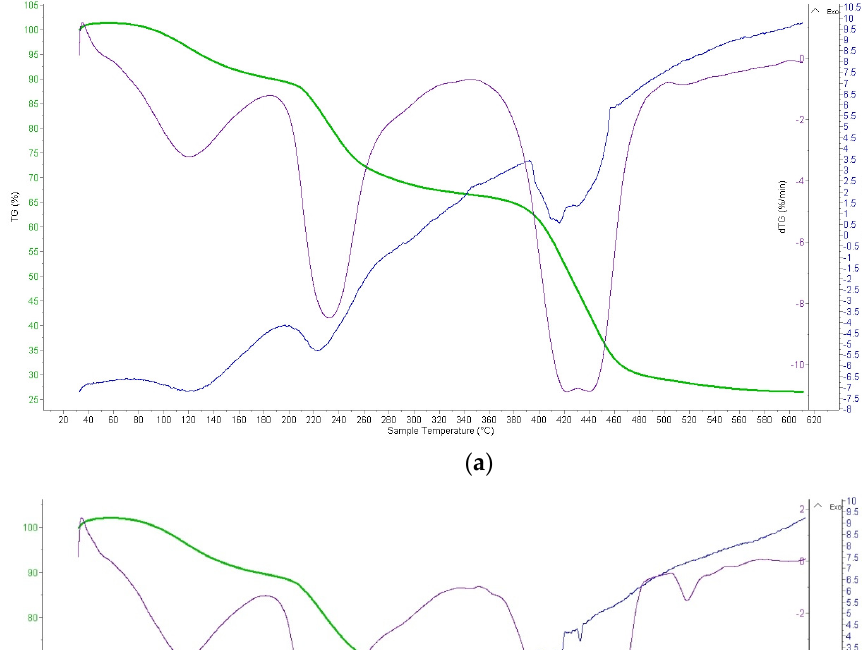
Figure 13. TGA curves of ( a ) mass loss and ( b ) rate of mass loss of Amberlite IR120. Figure 14 presents TGA curves of initial AB-17-8 (without sorbed europium), indi- vidual ion exchanger AB-17-8 with sorbed europium ions and AB-17-8 from ratio 1:5 with the sorbed metal ions from time of interaction 1.5 h.